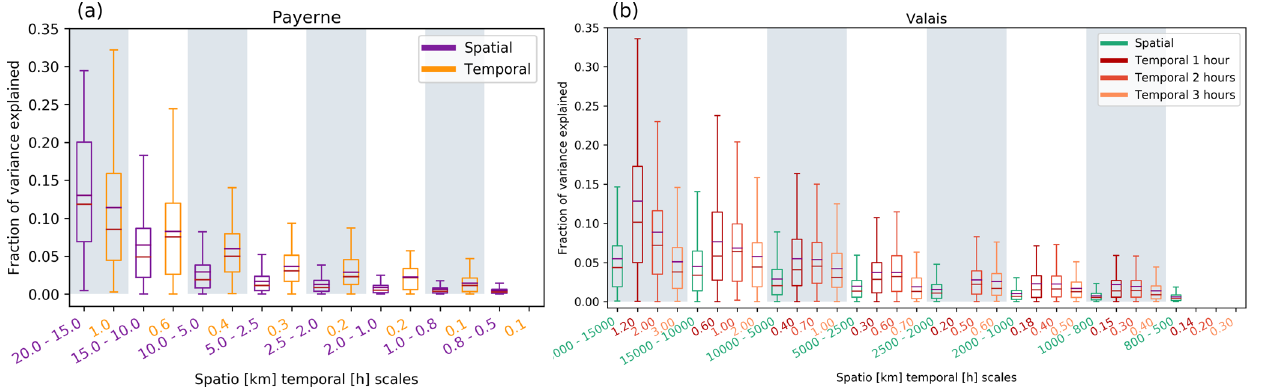
Figure 12. Box plots of the fractions of variance explained by components (binned) for the melting layer tops of the selected events for MXPol data in Payerne (a) and MXPol data in the Valais (b) . Spatial components are in purple and green, and temporal components are in orange for the Payerne data and in hues of red for the Valais data to distinguish the different time periods of 1, 2 and